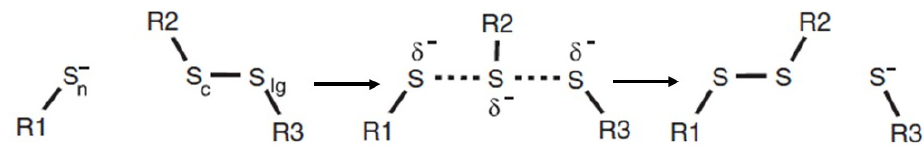
Figure 5. The orientation of a thiol and disulfide during thiol-disulfide exchange. S n is the nucleophilic sulfur of the thiolate reactant; S c and S lg are the central and leaving group sulfur atoms of the disulfide reactant Adapted with permission from [23]. Copyright (2013) Elsevier B.V.